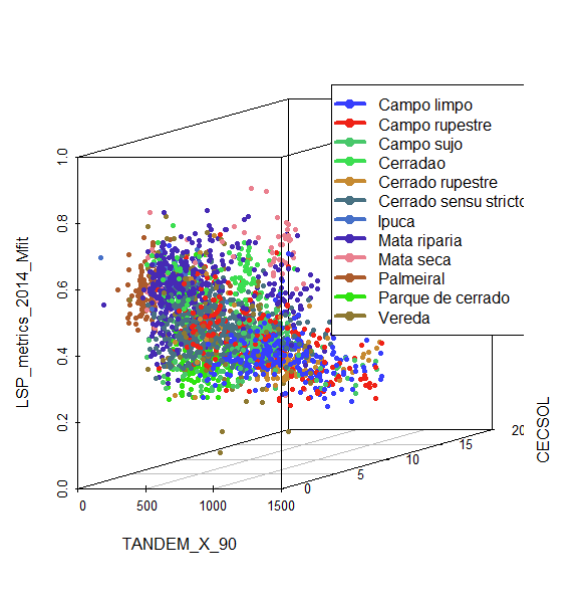
Figure 5. 3D-scatterplot of the three most important variables for the level-2 classification model based on the Gini importance